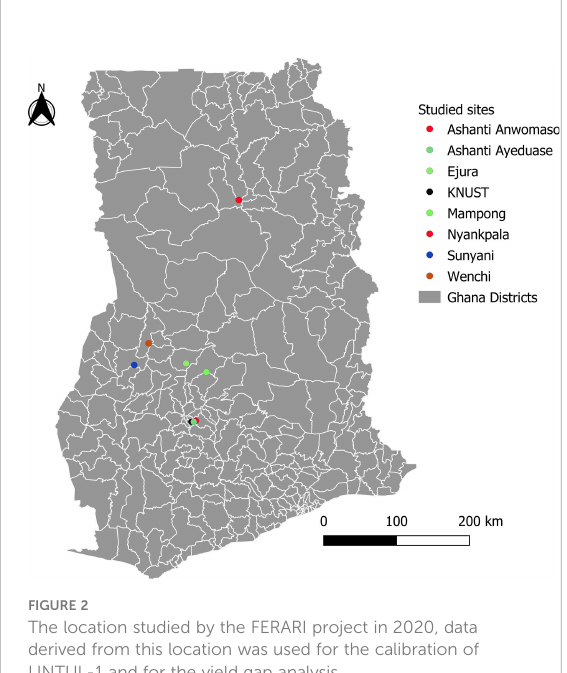
FIGURE 2 The location studied by the FERARI project in 2020, data derived from this location was used for the calibration of LINTUL-1 and for the yield gap